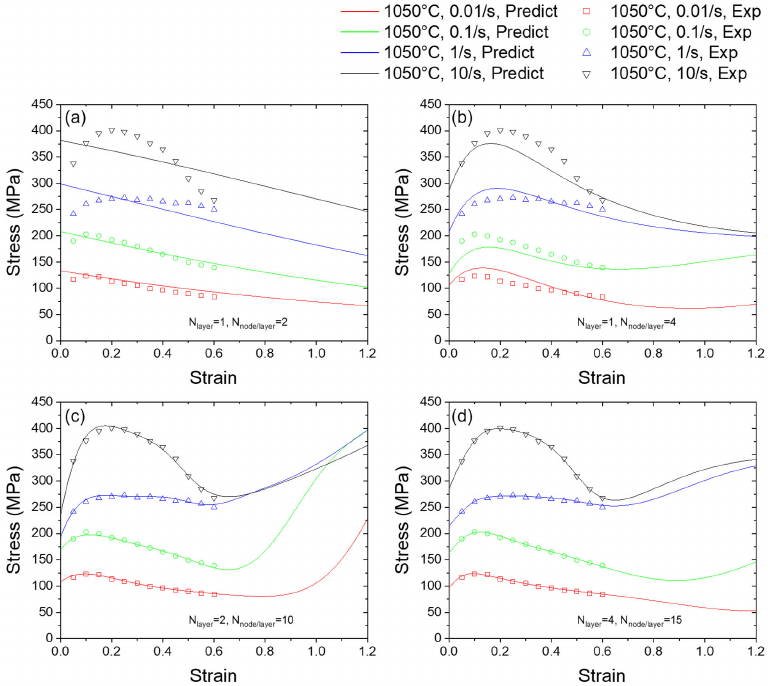
Figure 5. Predicted strain dependency of fl ow stress using ANNs with di ff erent structures. ( a – d ) are the predicted stress-strain curves by using ANNs with 1 × 2, 1 × 4, 2 × 10, 4 × 15 sizes.